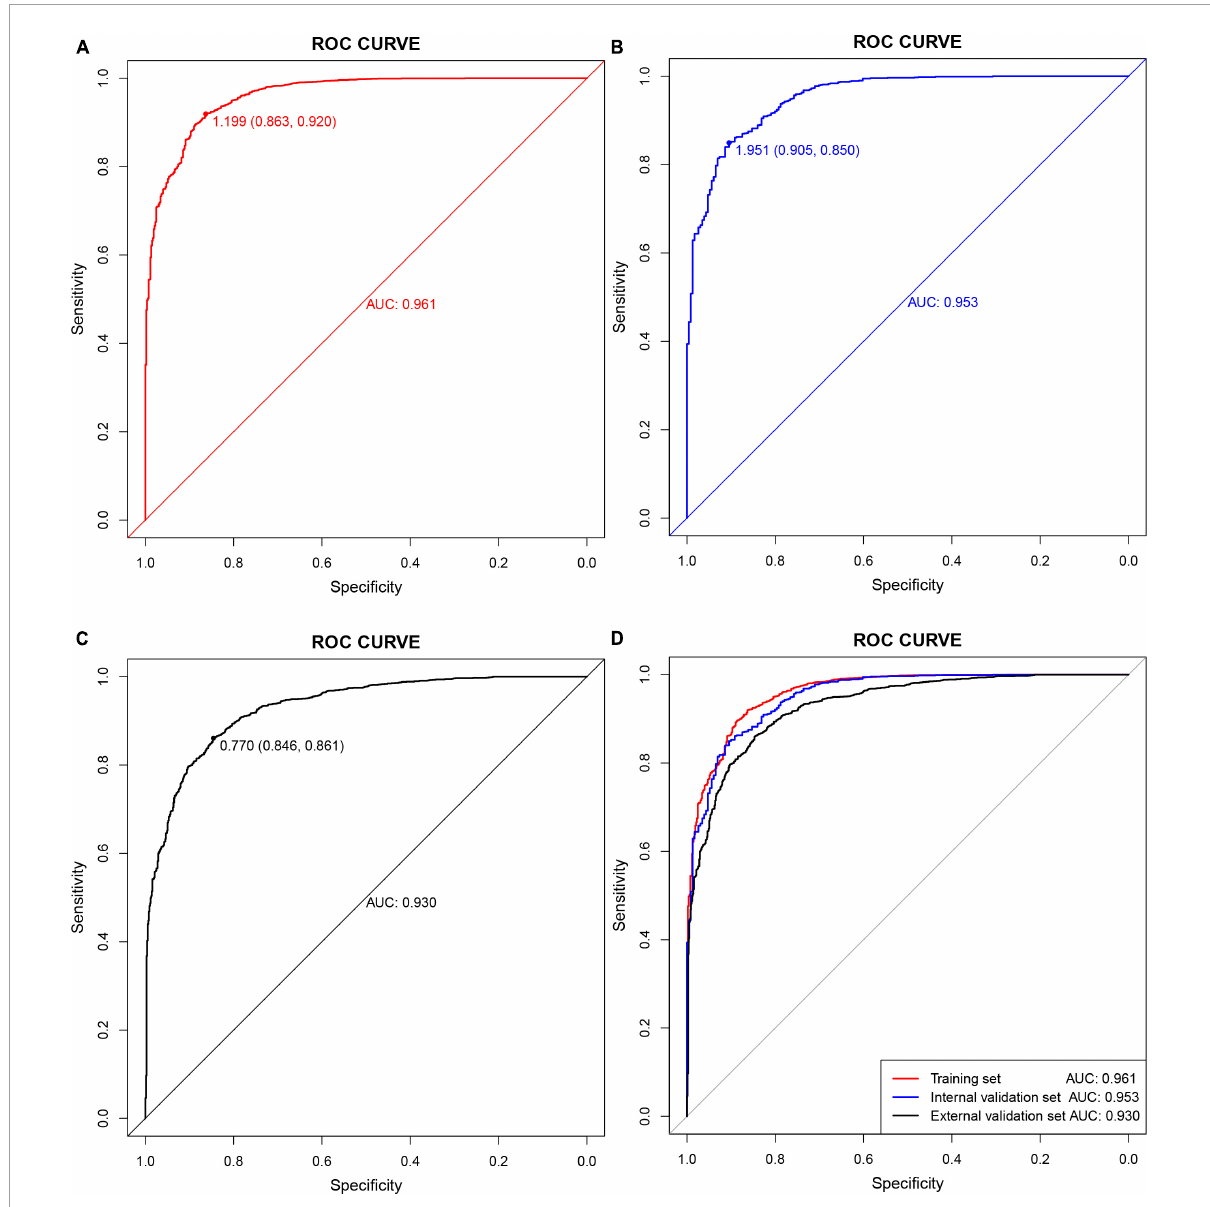
FIGURE5 Receiver operating characteristic (ROC) curves. (A) Training set; (B) internal validation set; (C) external validation set; (D) all sets.